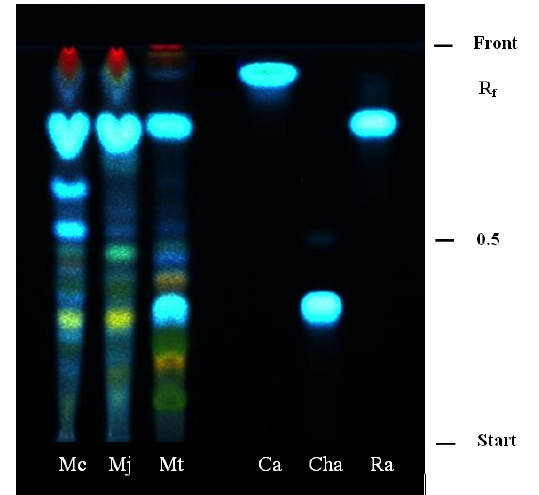
Figure 1. TLC chromatogram of phenolic acids in ethanolic extracts of the three selected Micromeria